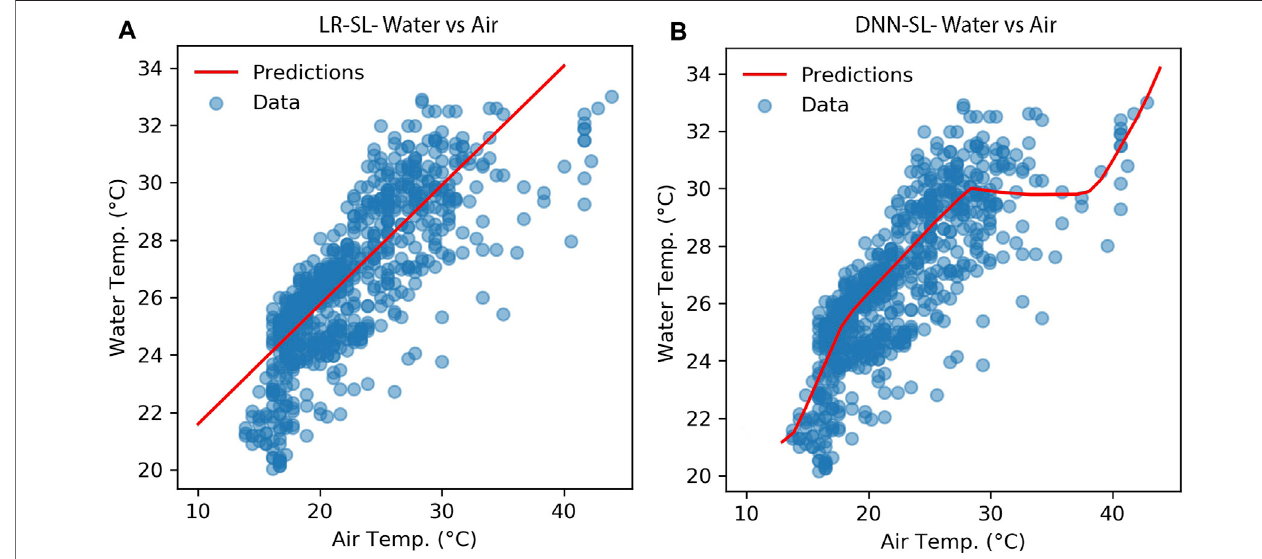
FIGURE5| Scatterplotsshowingtherelationshipoftheairand watertemperatureforthesingle-layertrainingapproachesusingthelinearregression (A) anddeep neural network (B) approaches. Panel b shows how the DNN model took the advantage the nonlinearity provided by the hidden layers.